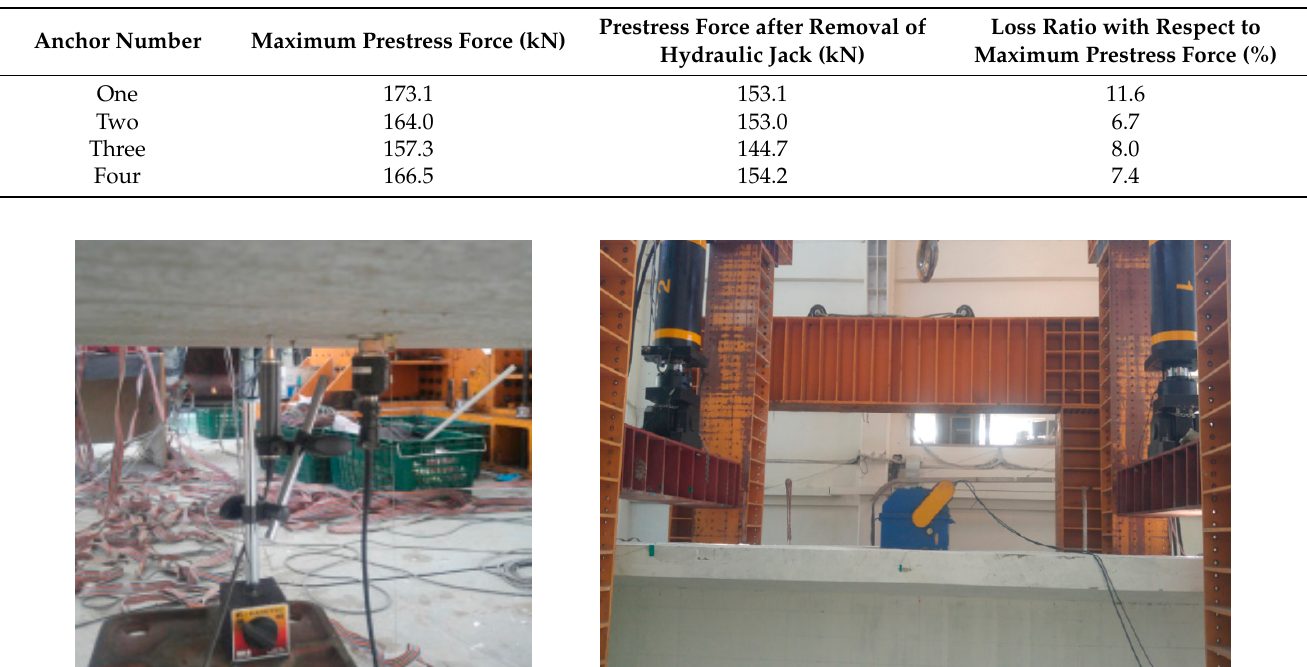
Table 3. Immediate loss of prestress force per anchor.